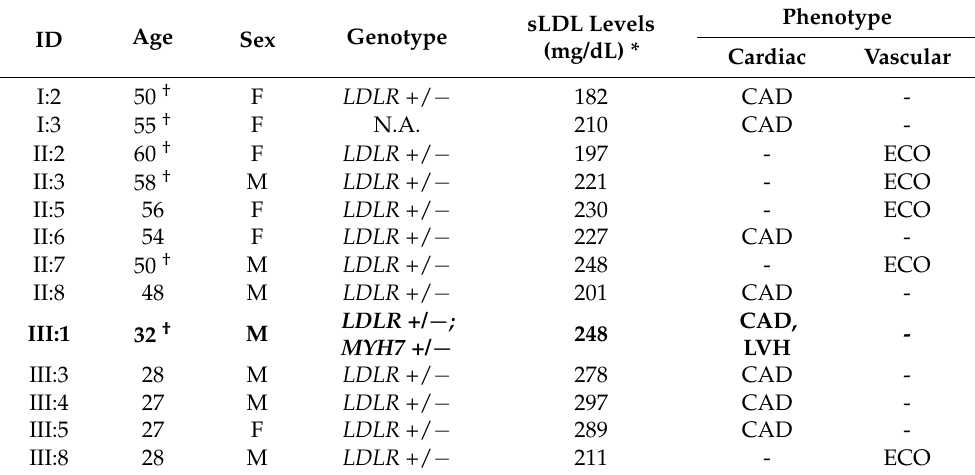
Table 2. Clinical and genetic data of proband family members with cardiac and vascular phenotype. Proband is highlighted in